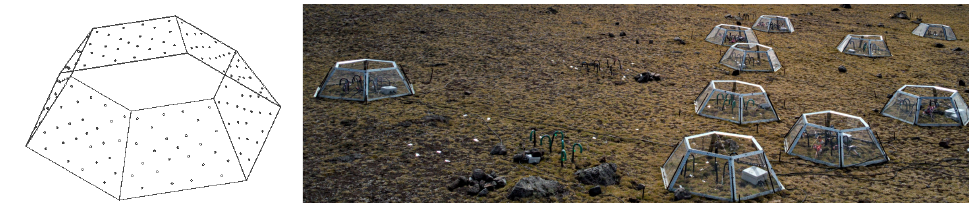
Figure 1. Visualization of an OTC chamber used in the experiments in order to simulate the day time warming and a photograph of a measurement spot (King George Island, South Shetlands), with OTC